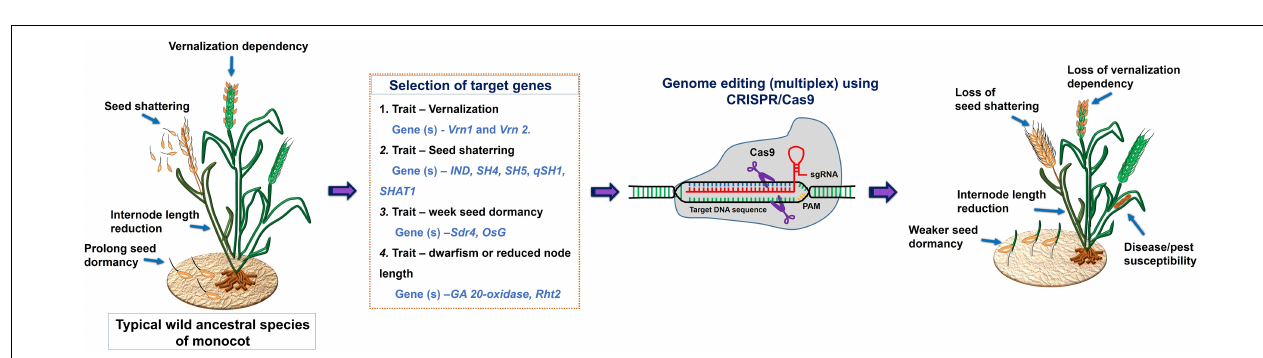
FIGURE 3 | A schematic representation of a draft model for the selection of target genes for CRISPR/Cas9 mediated domestication of wild ancestral species of monocot.